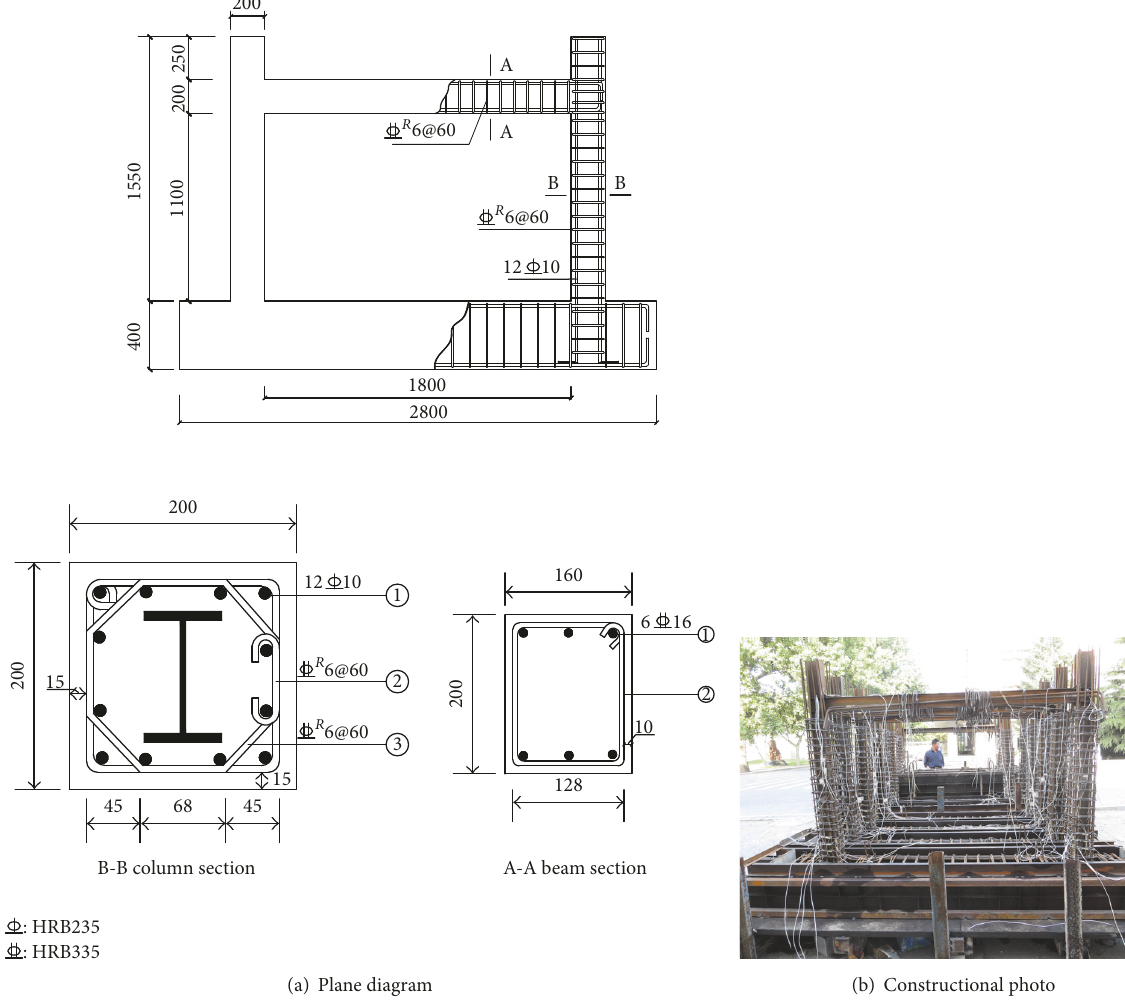
Figure 1: Frame reinforcement